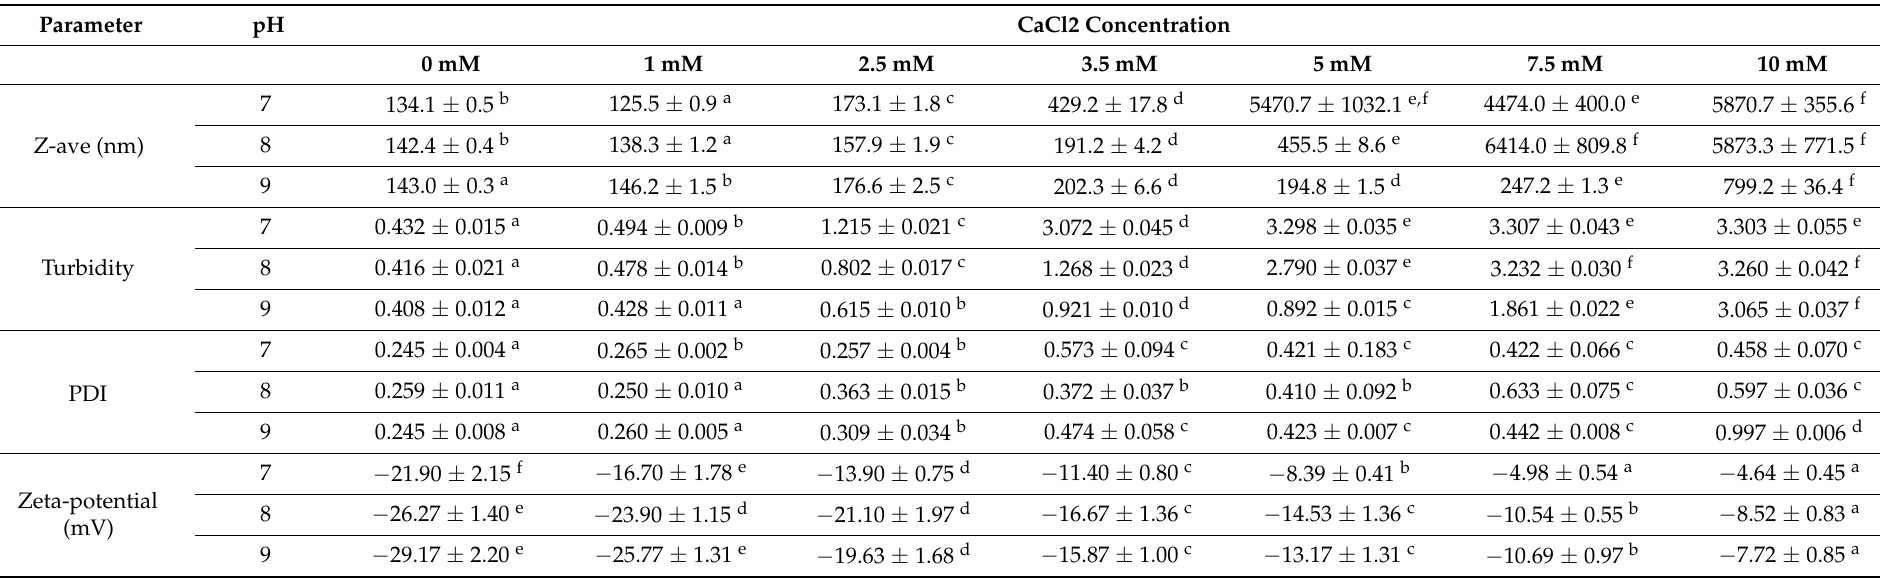
Table 8. Properties of peanut protein nanoparticles with variations in pH and the amount of Ca2+ ions. Reprinted with permission from ref. [130]. Copyright 2020 Elsevier.